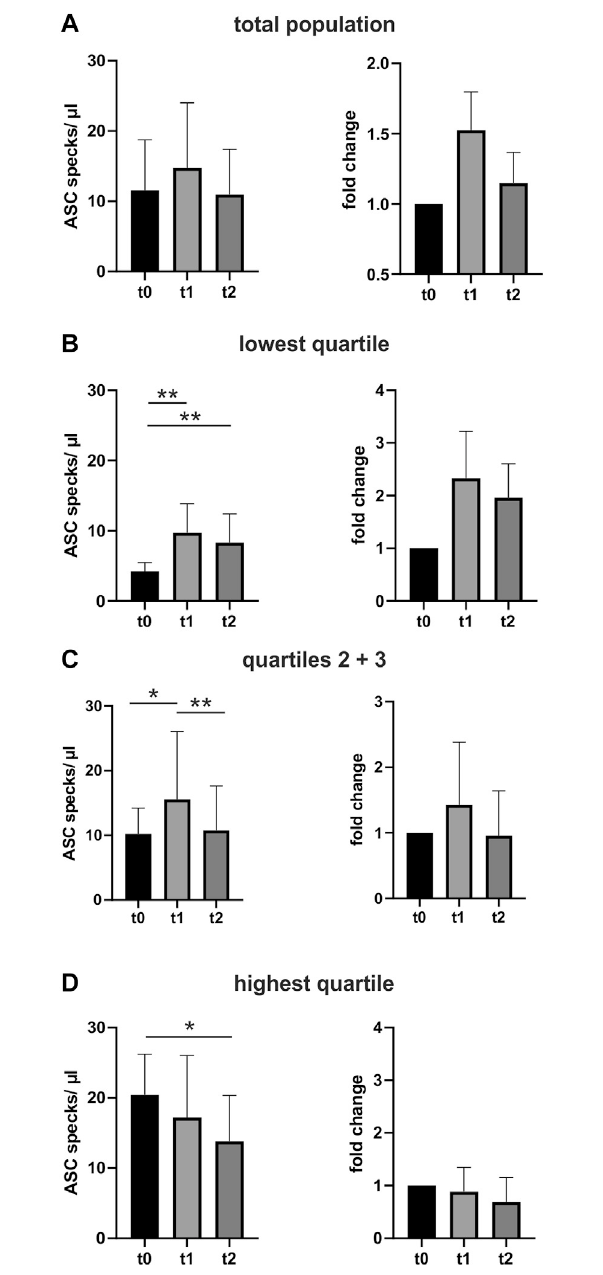
FIGURE 2 | Extracellular ASC speck concentration increases after performing a marathon run and decreases again in the days after. (A) ExtracellularASCspecksweremeasuredusing fl owcytometry.Sampleswere collected24 – 48 hbefore(t0)(N=52),immediatelyafter(t1)(N=52),and 2 – 3 days after the marathon run (t2) (N = 52). Absolute values of ASC specks per microliter serum and the individual fold change to t0 are depicted. (B – D) Subgroup analysis of the quartile with the lowest ASC speck concentration at t0 (B) , the middle group (C) , and the quartile with the highest (D) ASC speck concentration at t0. Data are expressed as mean +standard deviation * p < 0.05; ** p < 0.01. Mixed-effects analysis and the post-hoc Tukey test were used to analyze the